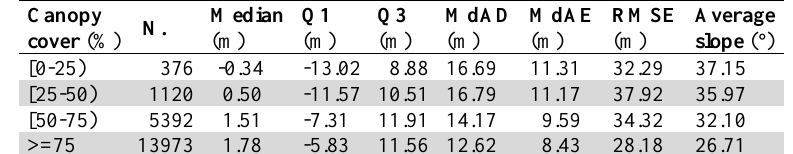
Table. A.1.2 Statistics related to errors from GEDI vs terrain height from discrete lidar divided in land cover categories. Canopy